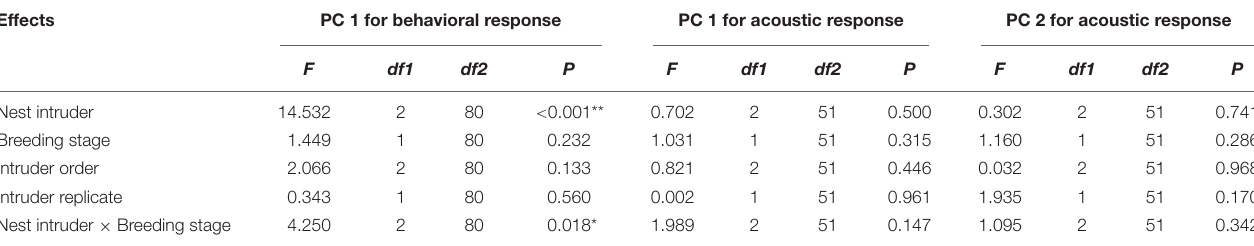
TABLE 3 | Generalized linear mixed model for behavioral and acoustic responses in A. orientalis.